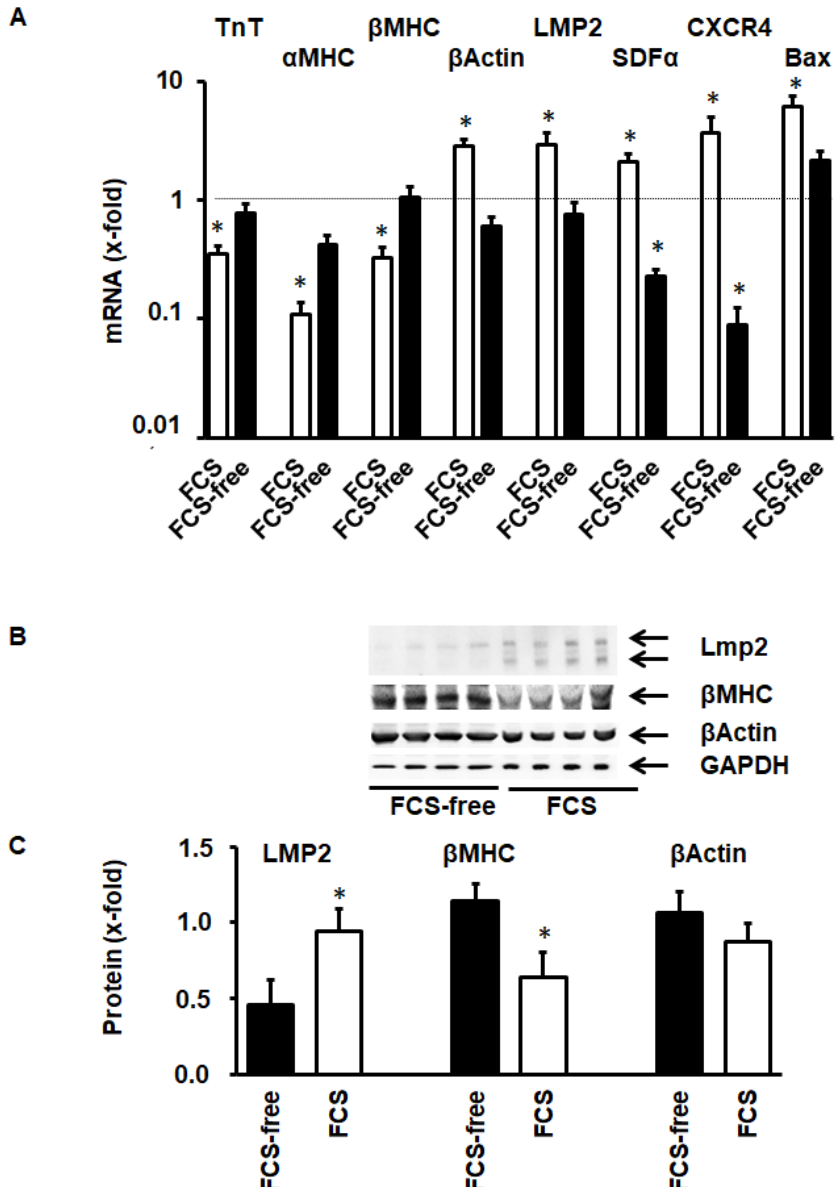
Figure 5. Protein expression in cultured cardiomyocytes within 48 h in the presence or absence of fetal calf serum (FCS). ( A ) mRNA expression of proteins of interest ( n = 6). ( B ) Representative western blot of LMP-2, myosin heavy chain, and β -actin. The double band of LMP-2 in B indicates activation of LMP-2 and incorporation into proteasomes. ( C ) Quantitative analysis of the western blot shown in B. Data are means ± SD. (*, p < 0.05 vs. FCS